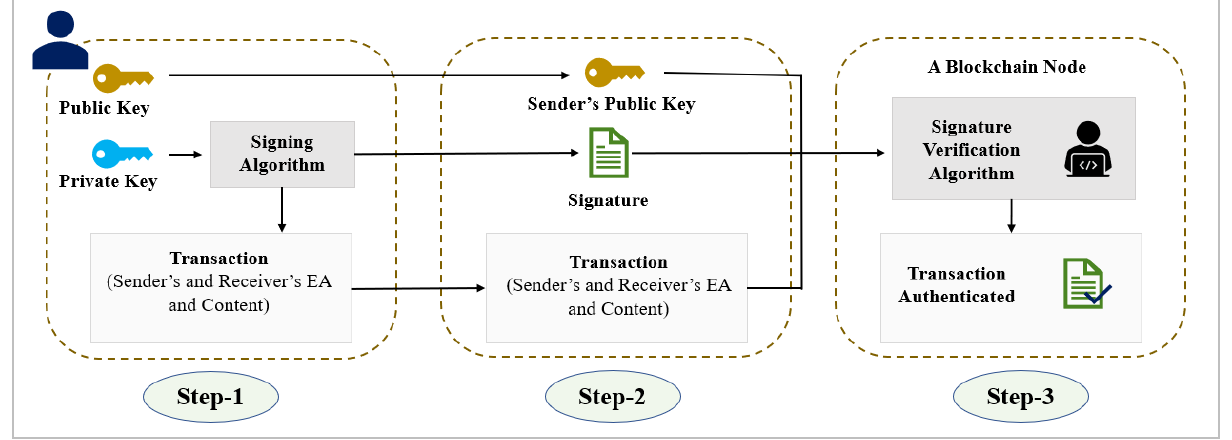
Figure 11. Transaction authentication process in a blockchain.